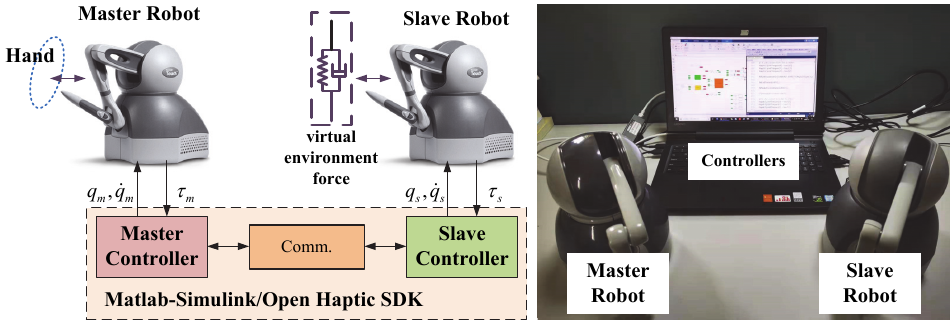
Figure 10. Experimental system used in our work, the left part is the system structure and the right side is the actual experiment system.